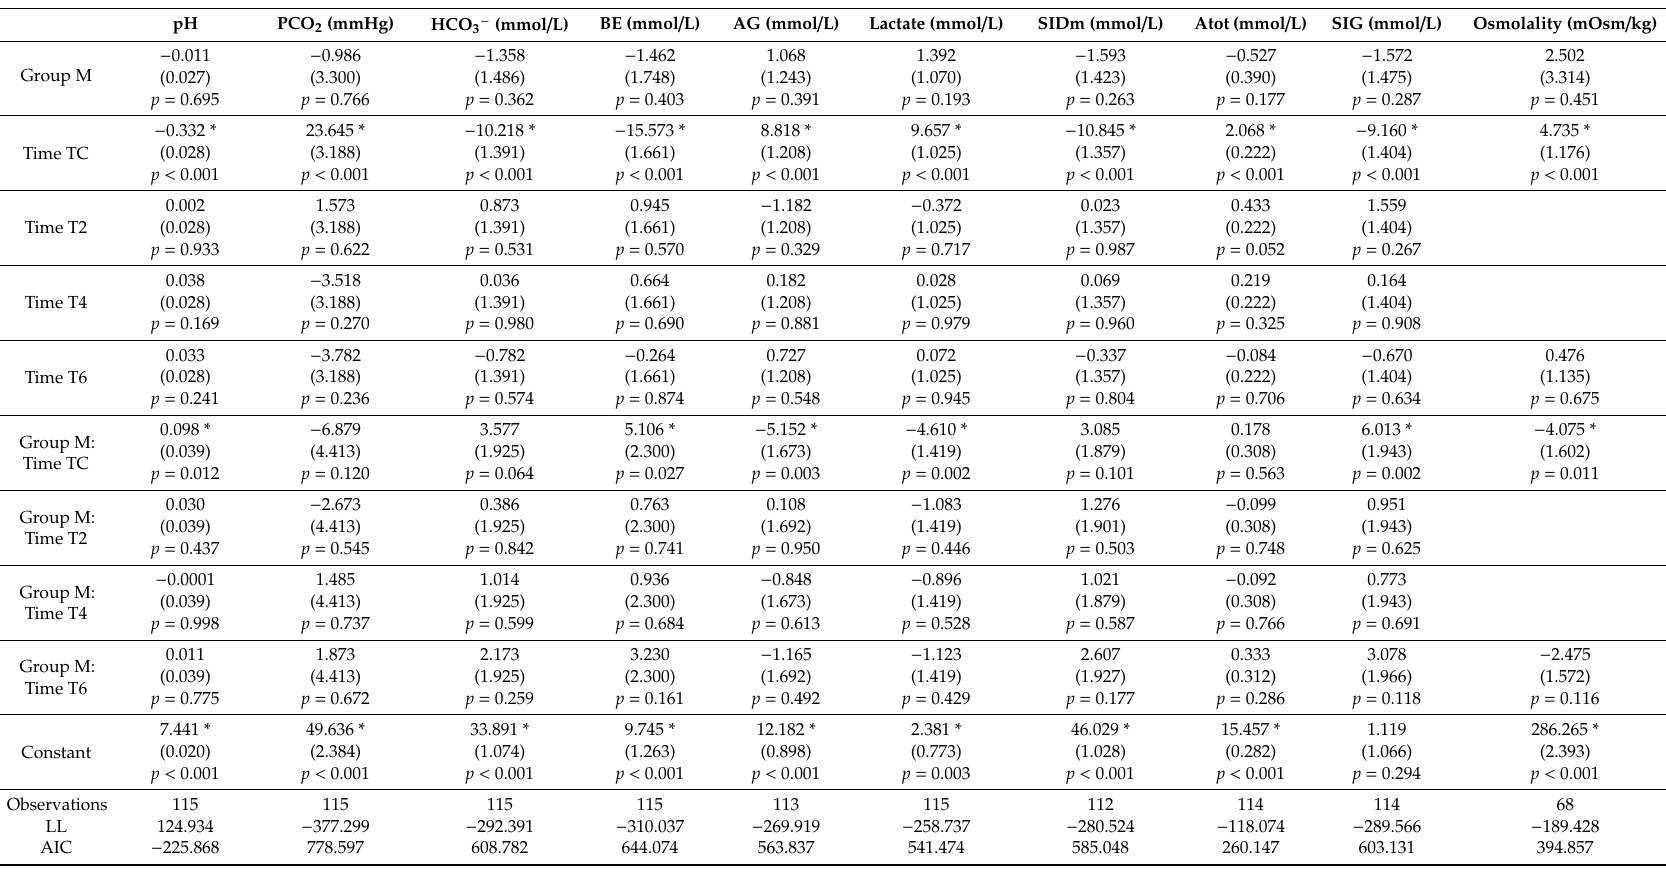
Table 2. Coe ffi cient estimates (standard errors) and p -values for time and group on pH, venous partial pressure of carbon dioxide (PCO 2 ), bicarbonate (HCO 3 − ), base excess (BE), anion gap (AG), lactate, measured strong ion di ff erence (SIDm), non-volatile weak acids (Atot), strong ion gap (SIG) and plasma osmolality. Time: capture (TC), start of transport (T0), and two (T2), four (T4) and six (T6) hours of transport. Groups: midazolam (Group M), azaperone (Group A). Reference category: Group A Time T0. The star indicates statistical significance ( p <